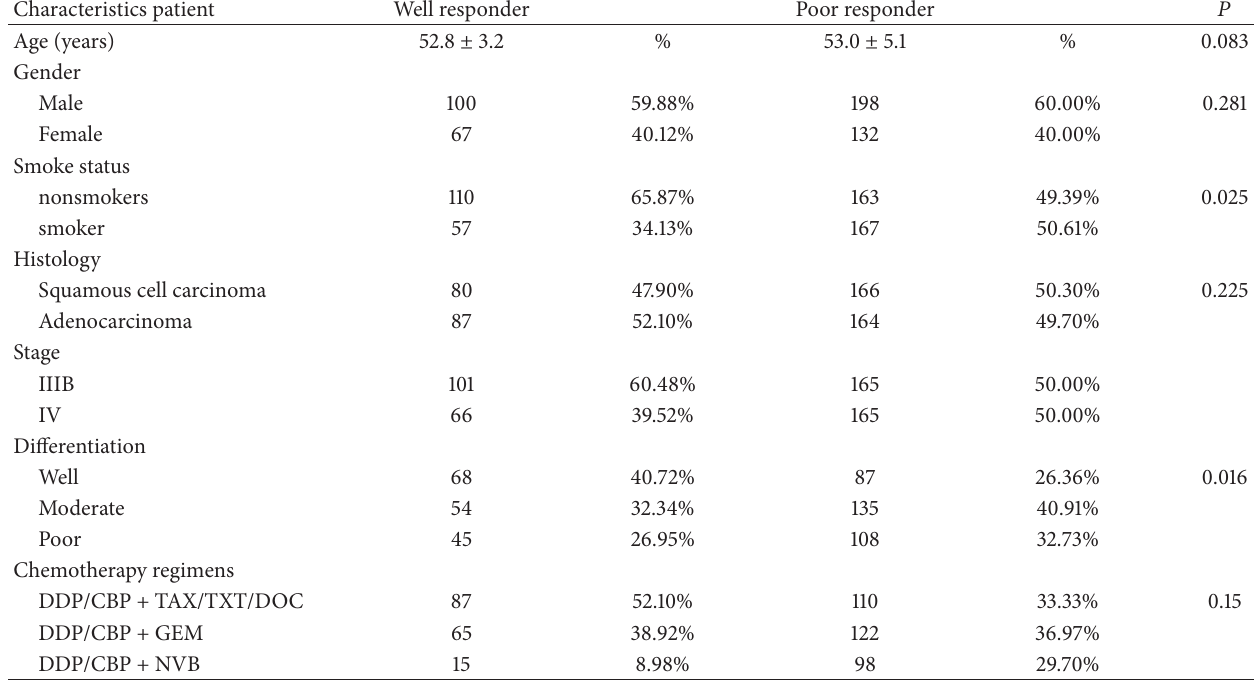
Table 1: Patient characteristics between well responder and poor responders to platinum-based chemotherapy.